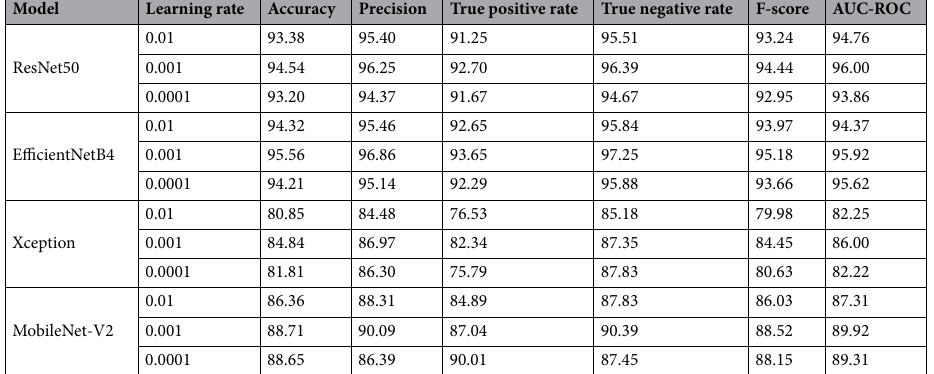
Table 2. Statistical fitness metrics of the residual network (ResNet), Xception, EfficientNetB4, and MobileNetV2 pre-trained conventional neural network (CNN) models in the detection of rust disease on sunflower, dry bean, and field pea using 0.01, 0.001, and 0.0001 learning rates. AUC-ROC = area under the receiver operating characteristic curve. All units are in